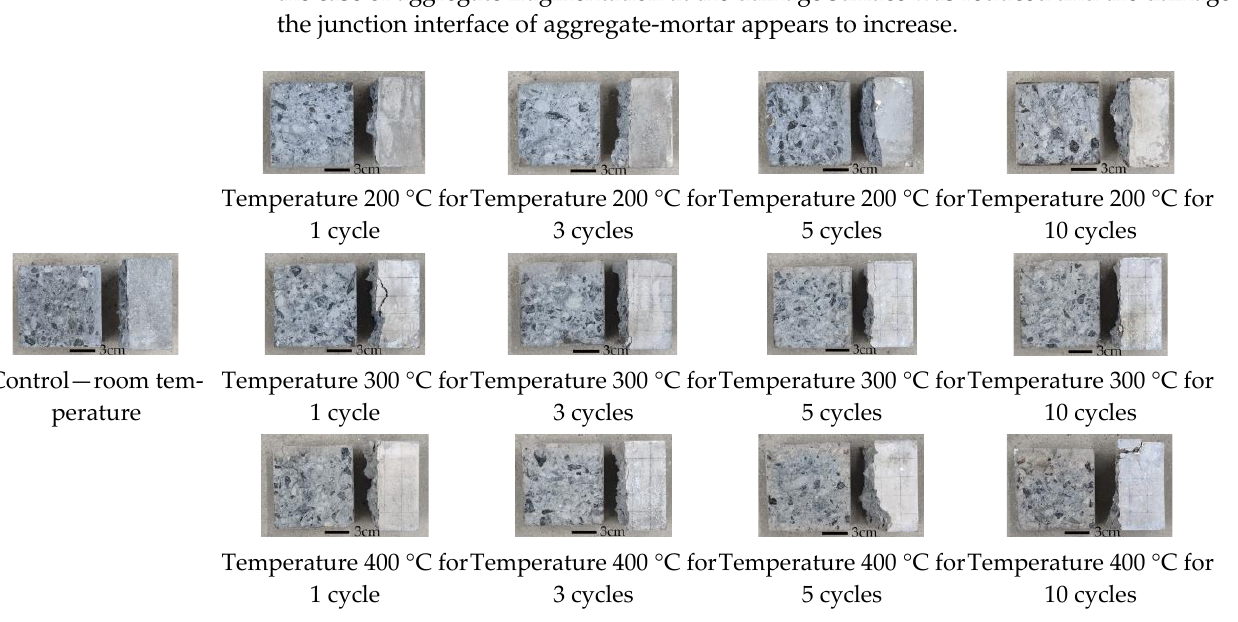
Table 4. Splitting tensile strength of magnetite concrete exposed to multiple heating at high temper- ature.